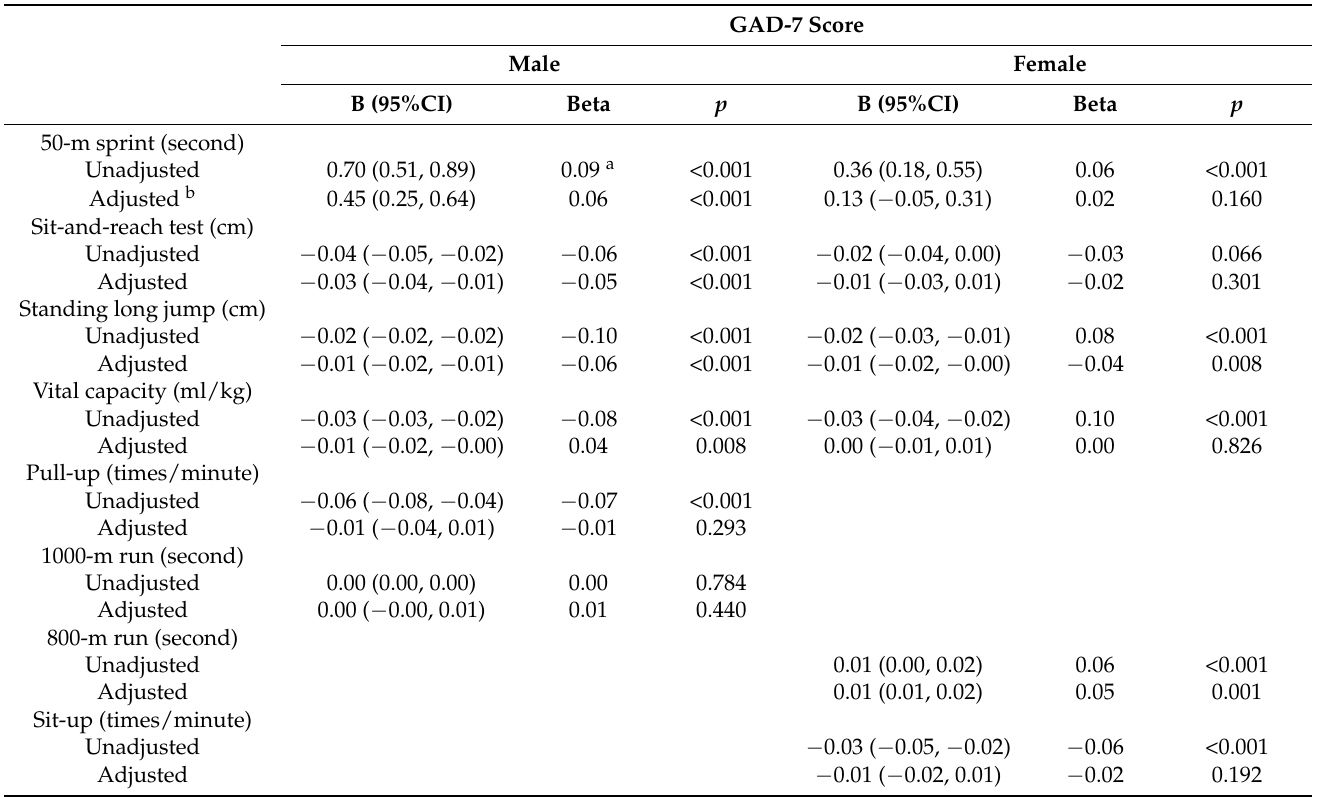
Table 2. Multivariate linear regression models with GAD-7 score as dependent variable.